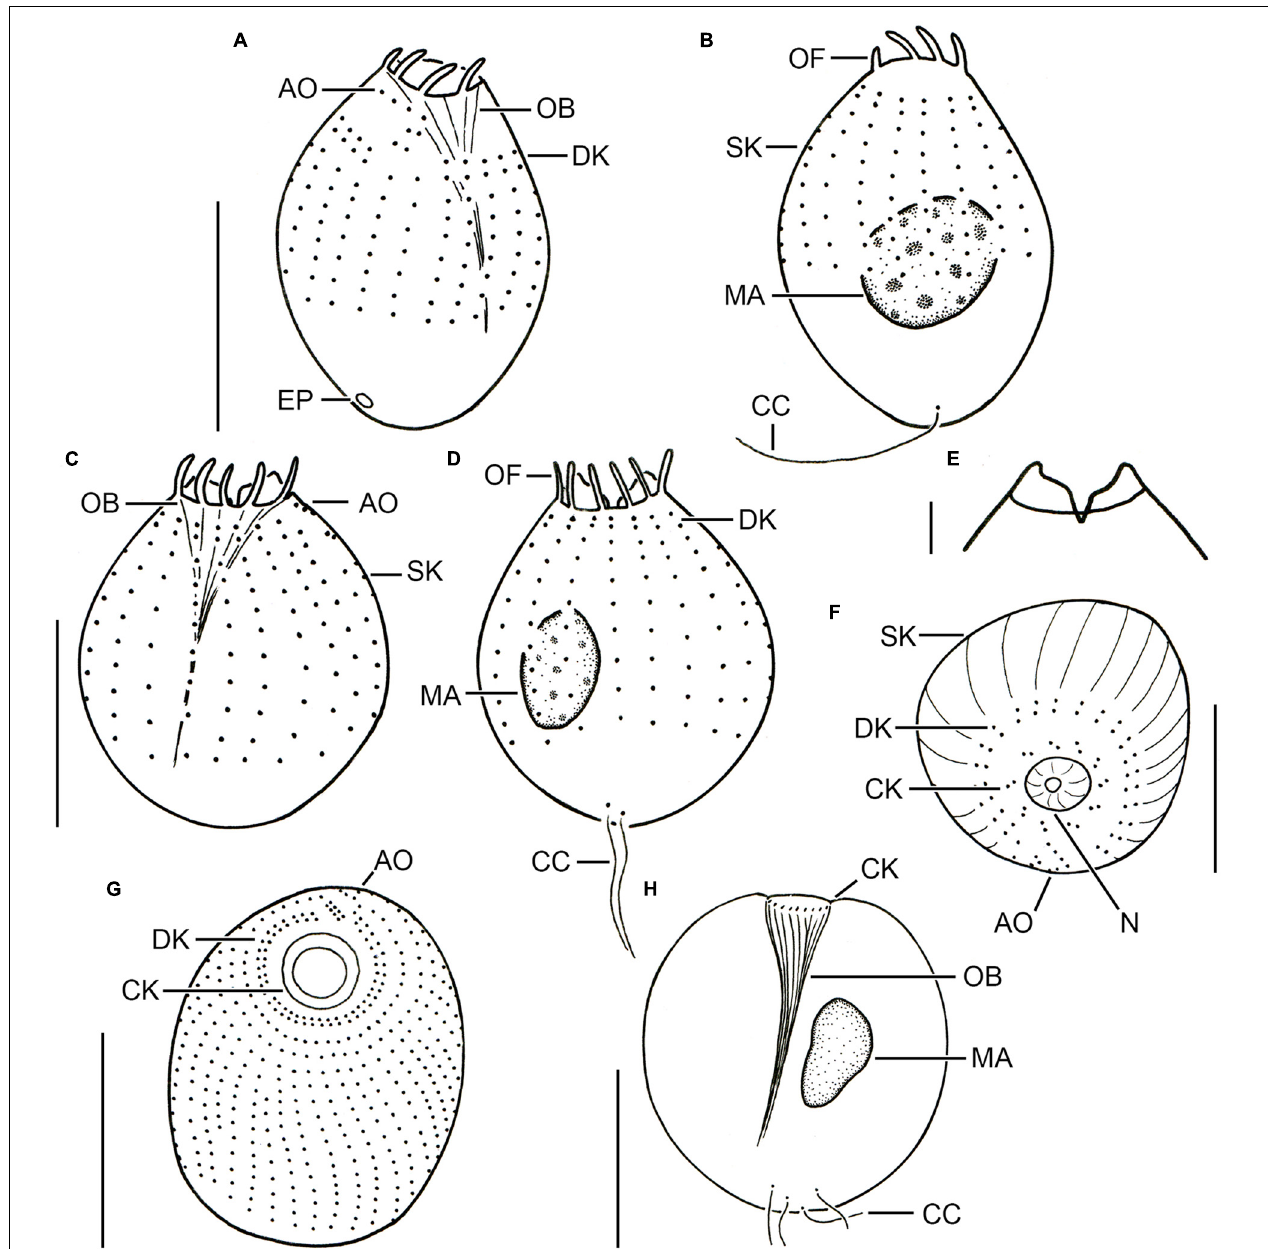
FIGURE 2 | Different urotrich morphotypes after protargol staining. (A,B) Ventral and dorsal views of a specimen of strain CIL-2017/24 from Lake Mondsee tentatively identified as Urotricha agilis. Occasionally, only the ciliated basal bodies of the adoral organelles stain. (C–F) Urotricha furcata , specimens of strain CIL-2019/6 from Lake Zurich. Right (C) and left (D) lateral views of same specimen. Optical section of the protruding oral region (E) . Oblique top view (F) . (G,H) Specimens of strain CIL-2019/1 from Lake Zurich tentatively identified as U. castalia . Oblique top view (G) ; the concentric circles denote the circumoral kinety. Schematic optical section (H) . AO, adoral organelles; CC, caudal cilia; CK, circumoral kinety; DK, dikinetids at anterior end of somatic kineties; EP, excretory pore; MA, macronucleus; N, nematodesmata (oral basket rods); OB, oral basket; OF, oral flaps; SK, somatic kineties. Scale bars 10 µ m (A–D,F) , 2 µ m (E) , and 20 µ m (G,H)